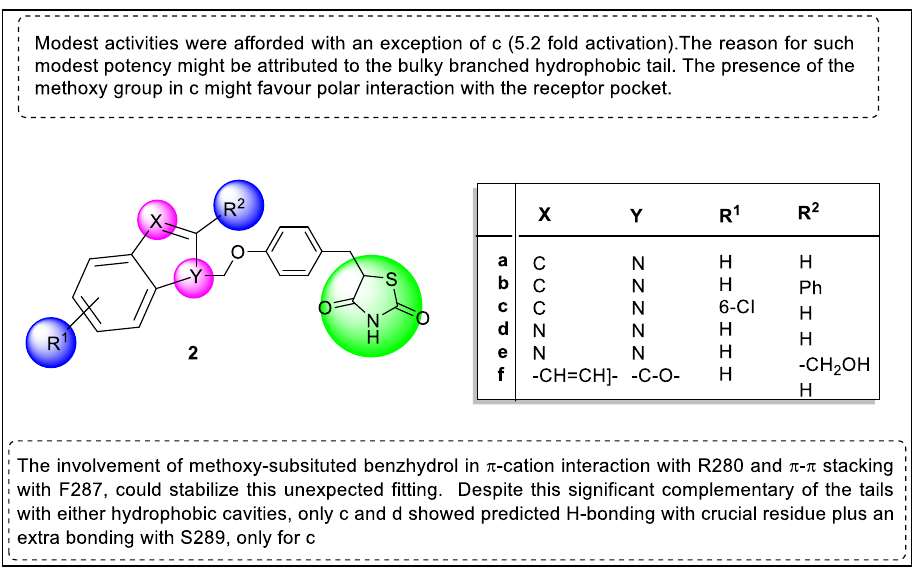
Figure 7. Structural activity relationship of thiazolidinedione hybrids ( 2 ) as potent PPAR ligands.